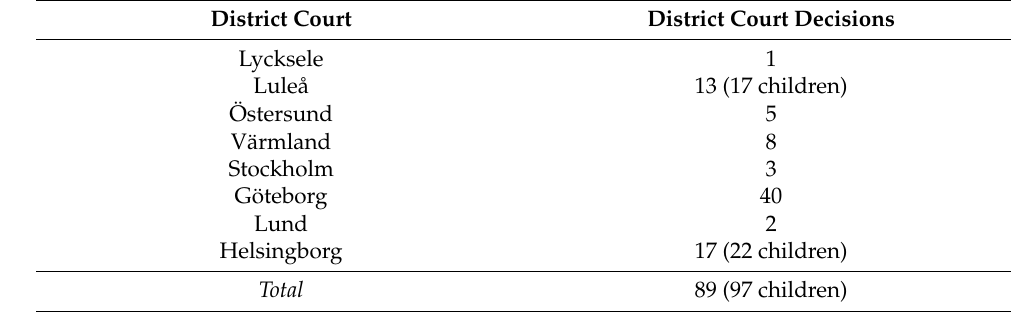
Table 1. Decisions